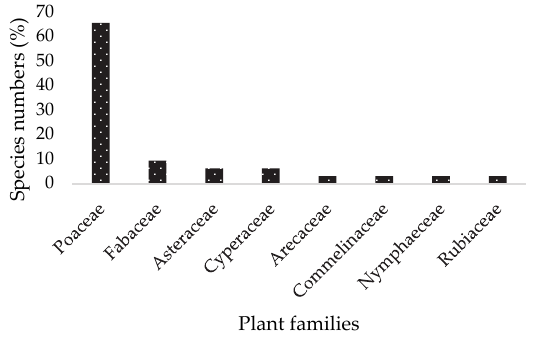
Figure 1. Plant families in the study sites.